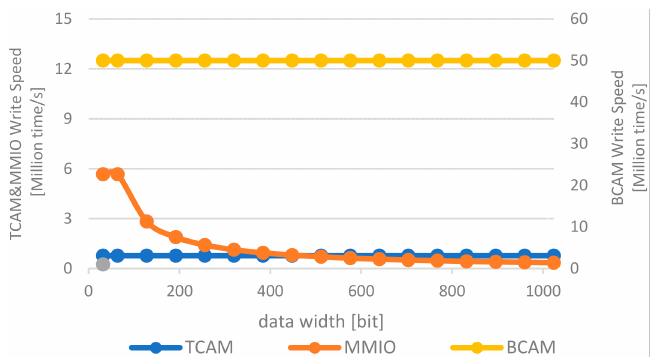
Figure 24. The write speed of TCAM, MMIO, and BCAM. Table 5. Limiting performance of three operations of rule